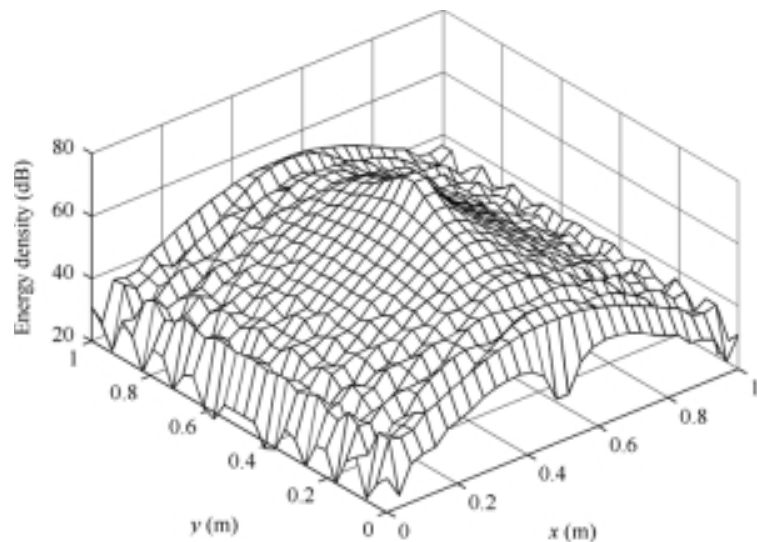
Fig. 15. The classical energy density distribution of the orthotropic plate when f = 5 kHz and η = 0 . 2 . The reference energy density is 1 × 10 − 12 J/m 2 .